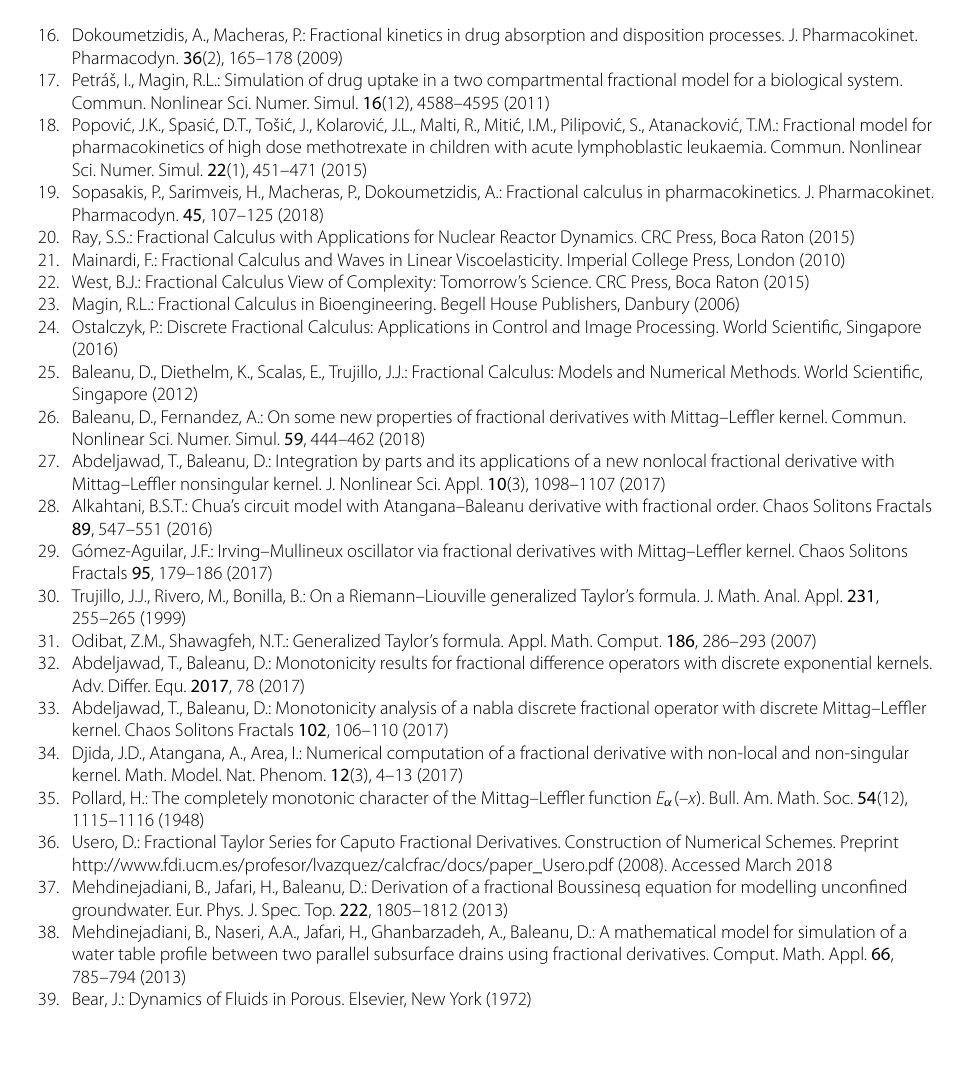
water table profile between two parallel subsurface drains using fractional derivatives. Comput. Math. Appl. 66 , 785–794